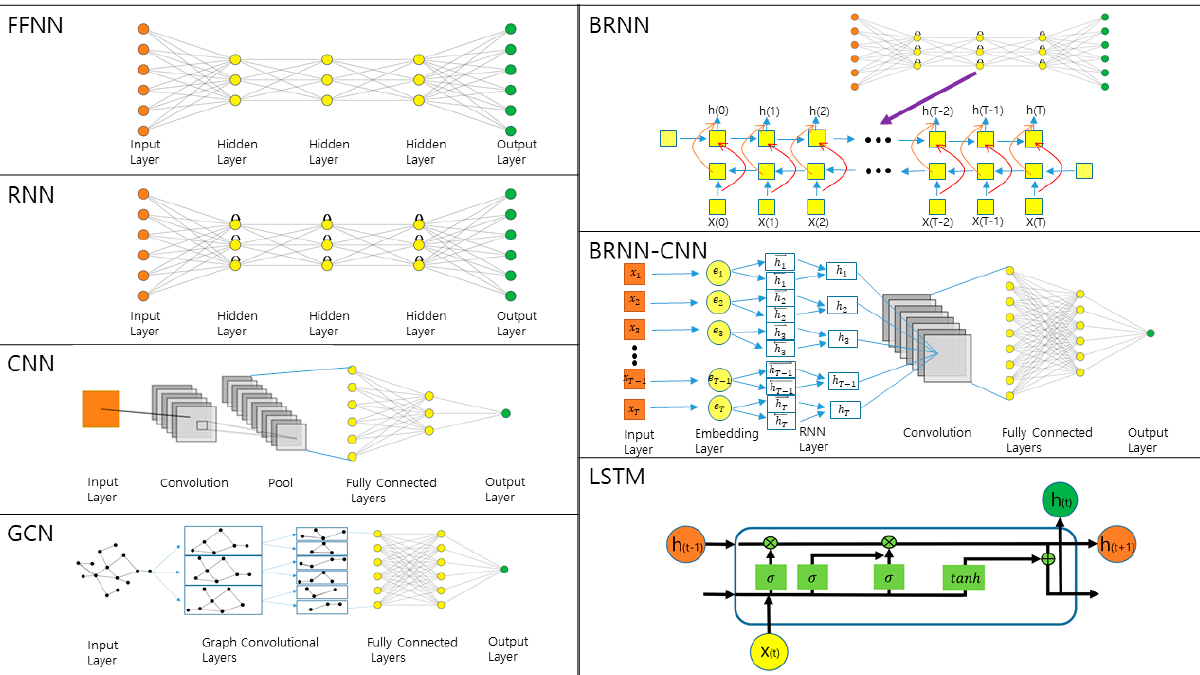
Figure 1. Overview of deep learning (DL) architectures frequently used for protein structure prediction .